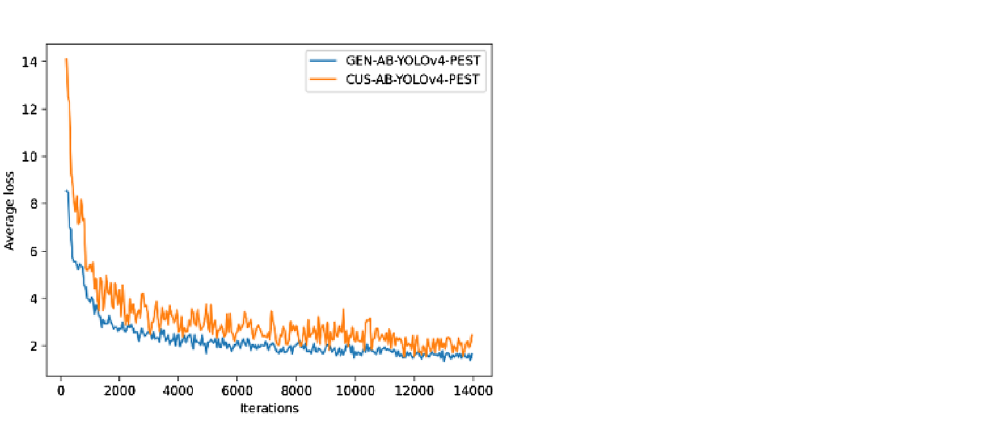
Figure 9. Average loss curves of training phase.